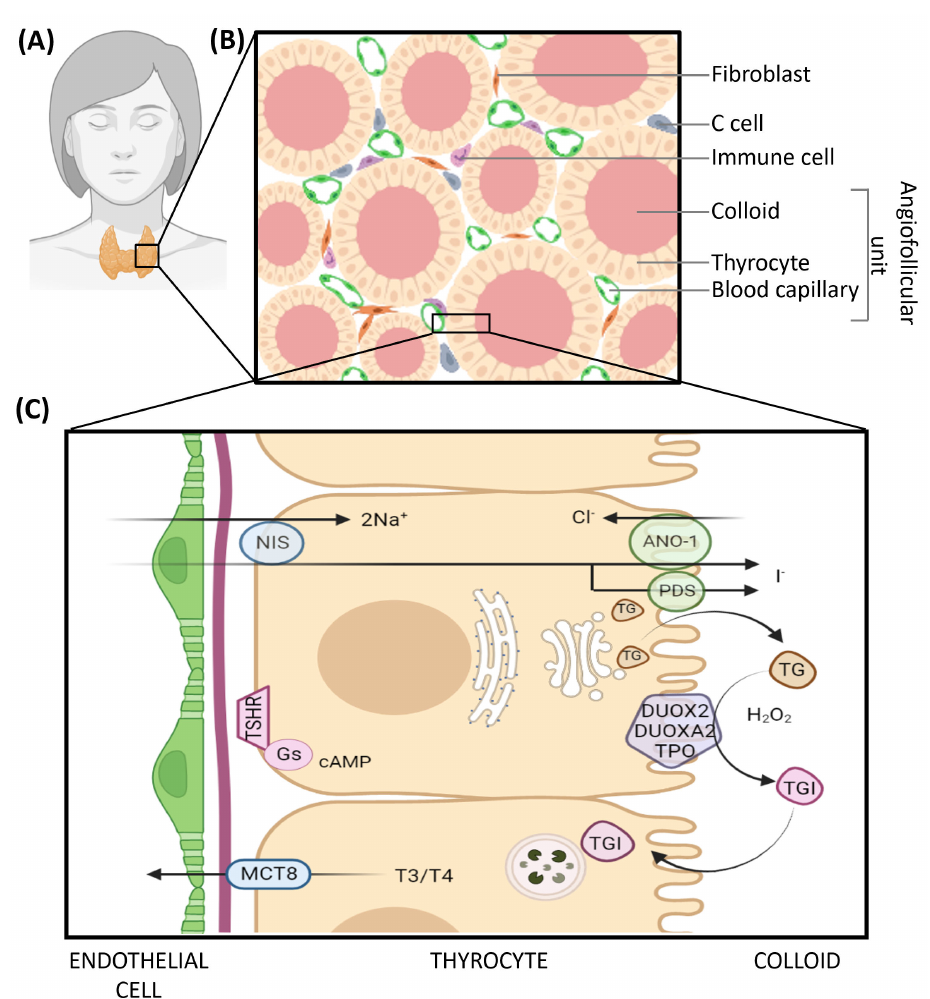
Figure 1. Histology and function of the healthy thyroid gland. ( A ) Anatomical localization of the gland. ( B ) Schematic representation of the thyroid parenchyma. ( C ) Oversimplified representation of thyroid hormone synthesis with major actors. The synthesis of thyroid hormones, namely thyroxine or tetra-iodothyronine (T4) and tri-iodothyronine (T3), begins in thyrocytes with the expression of thyroglobulin (TG). TG is glycosylated in the Golgi and secreted by exocytosis in the follicular lumen. Concomitantly, thyrocytes captures iodide (I − ) from the bloodstream via the sodium/iodine symporter (NIS) located at their basolateral pole. Cytoplasmic iodide is then transferred across the apical membrane into the lumen via Anoctamin-1 (ANO-1) and Pendrin (PDS). Within the lumen, iodide is oxidized to di-iodine (I 2 ) and serves as a substrate for thyroglobulin iodination on tyrosine residues. TPO catalyzes the covalent binding of mono-iodide or di-iodide to tyrosine residues of thyroglobulin (MIT or DIT) and different coupling reactions between modified residues thereby generating iodinated thyroglobulin (TGI). Those reactions require the presence of H 2 0 2 generated by DUOX2 and DUOXA2 proteins. Upon TSH binding to its receptor at the basal membrane, colloid droplets are endocytosed (among other events), and endosomes fuse with lysosomes. TGI is hydrolyzed by lysosomal proteases, and the released T3/T4 hormones are transported in the cytoplasm. They are finally exported from the thyrocyte to the extracellular milieu via the monocarboxylate transporter MCT8; they cross the basal lamina and reach the blood flow through the fenestrated